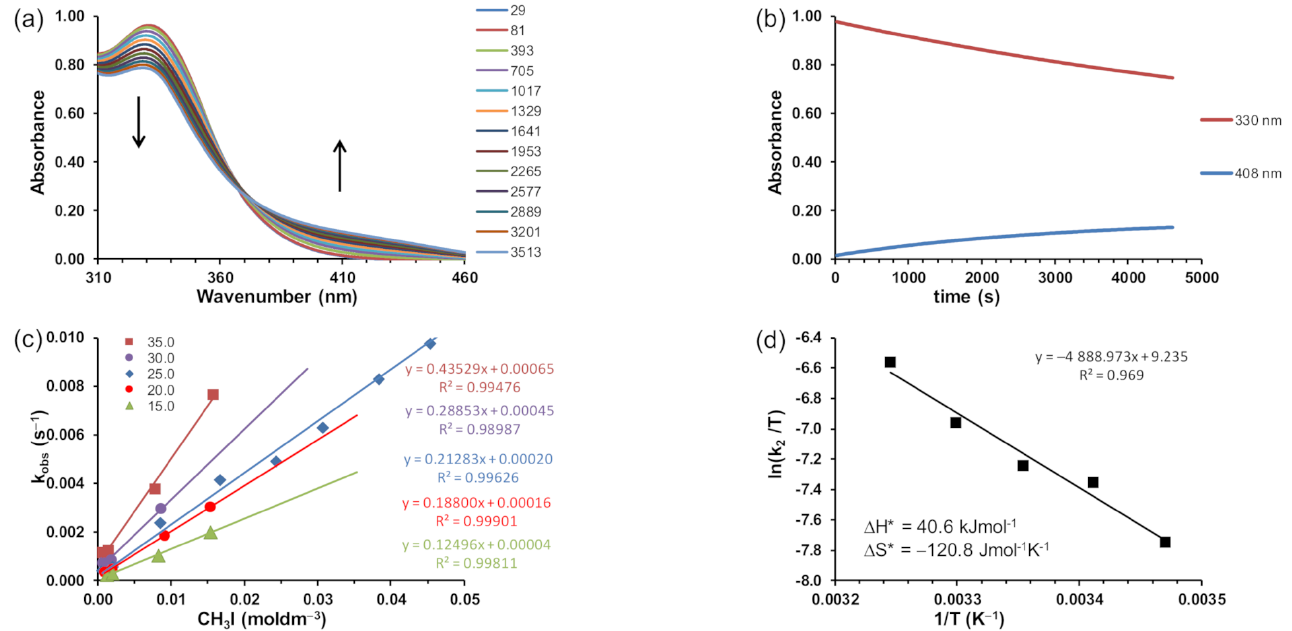
Figure 4. ( a ) UV–Vis spectra of the reaction between [Rh(CH 3 COCHCNHCH 3 )(CO)(PPh 3 )] 3A and 0.008384 mol dm − 3 CH 3 I concentration in 50 × excess, with respect rhodium concentration at the indicated time in s. ( b ) The [Rh(CH 3 COCHCNHCH 3 )(CO)(PPh 3 )] 3A + CH 3 I reaction, as monitored at the indicated wavelengths with time. ( c ) Graph of the observed kinetic rate constants against the concentrations of the reaction between [Rh(CH 3 COCHCNPhCH 3 )(CO)(PPh 3 )] 3B and CH 3 I at 15, 20, 25, 30, and 35 ◦ C, obtained from UV–Vis data at 404 nm. ( d ) Eyring plot of the 3B and CH 3 I reaction in ( c ).